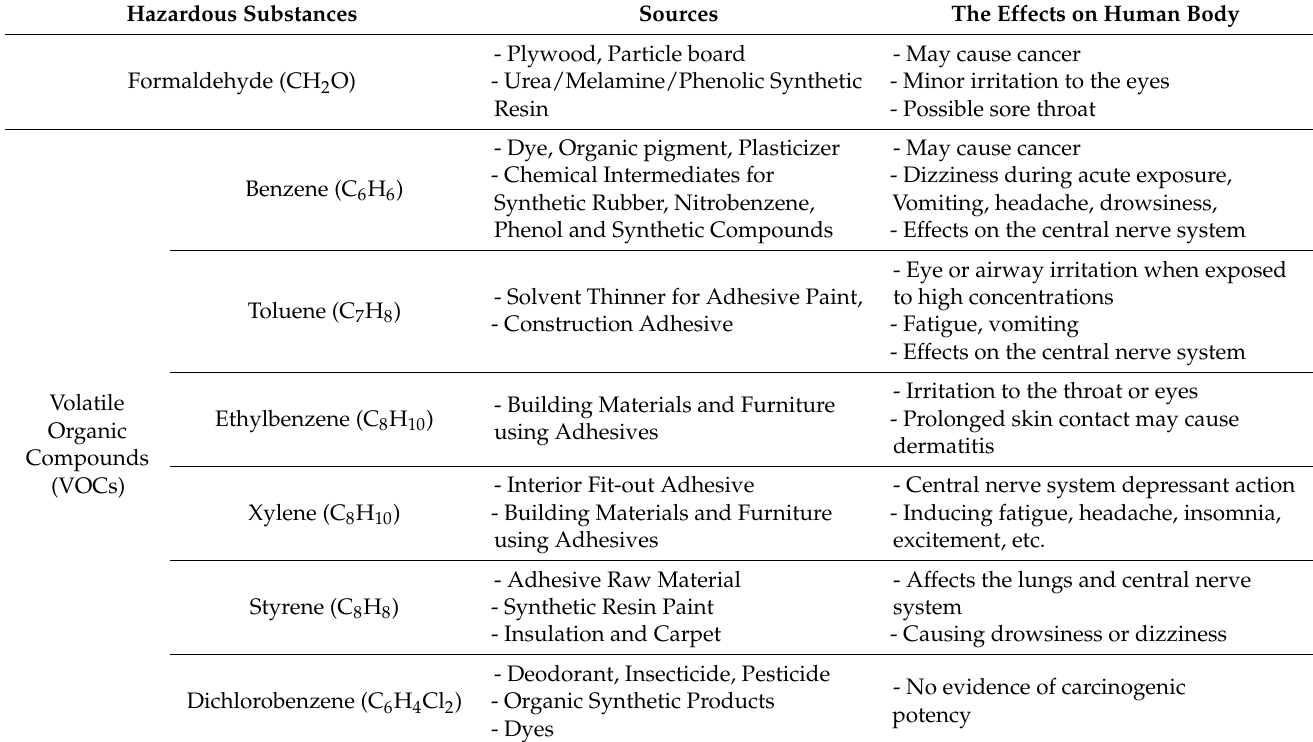
Table 1. The effects of hazardous substances on the human body.